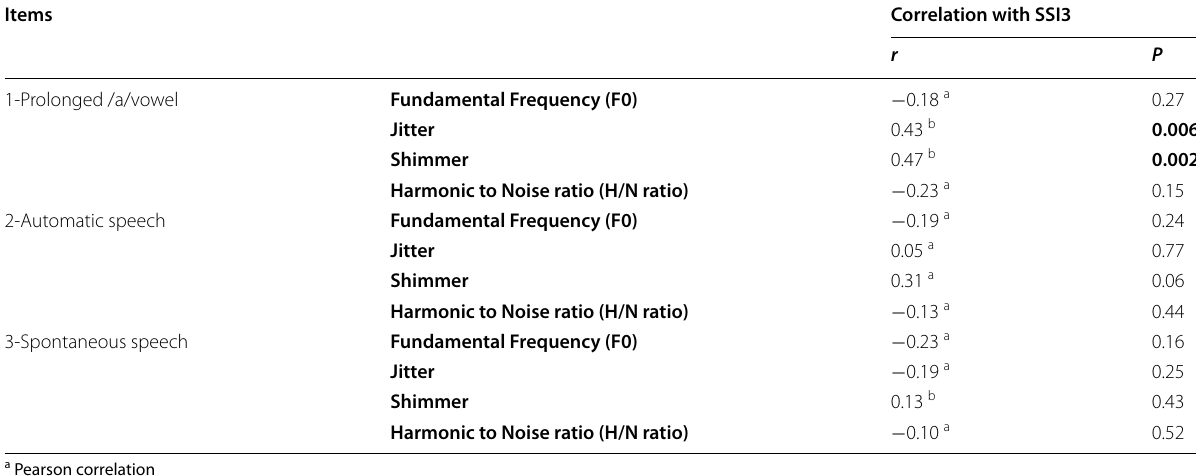
Table 7 Correlation between acoustic parameters and SSI3 in the stuttering group